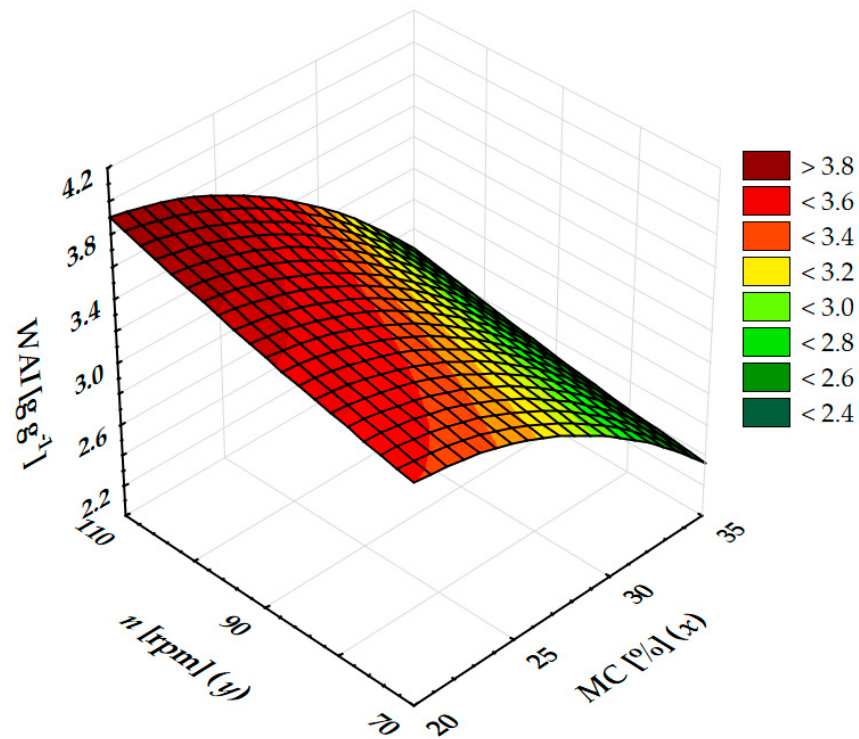
Figure 4. The influence of the rotational speed of the extruder screw and the level of raw material moisture on the water absorption index ( WAI moisture on the water absorption index ( WAI).